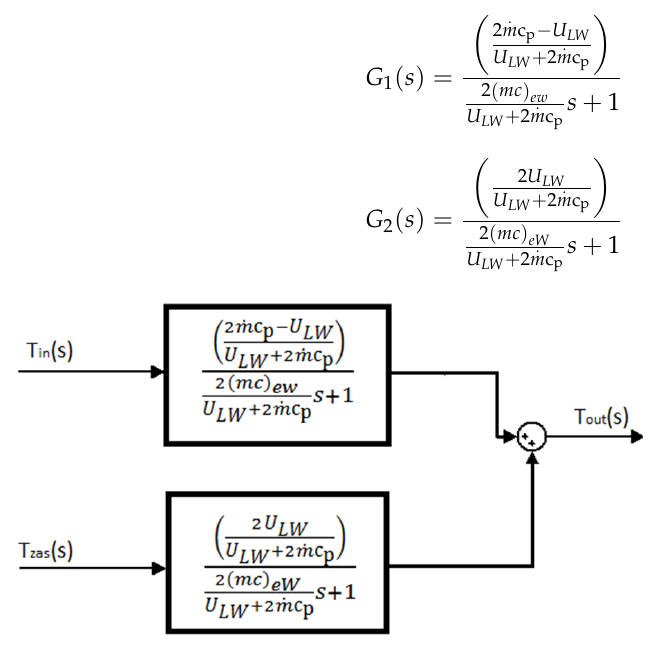
Figure 1. Block diagram of the coil heat exchanger.